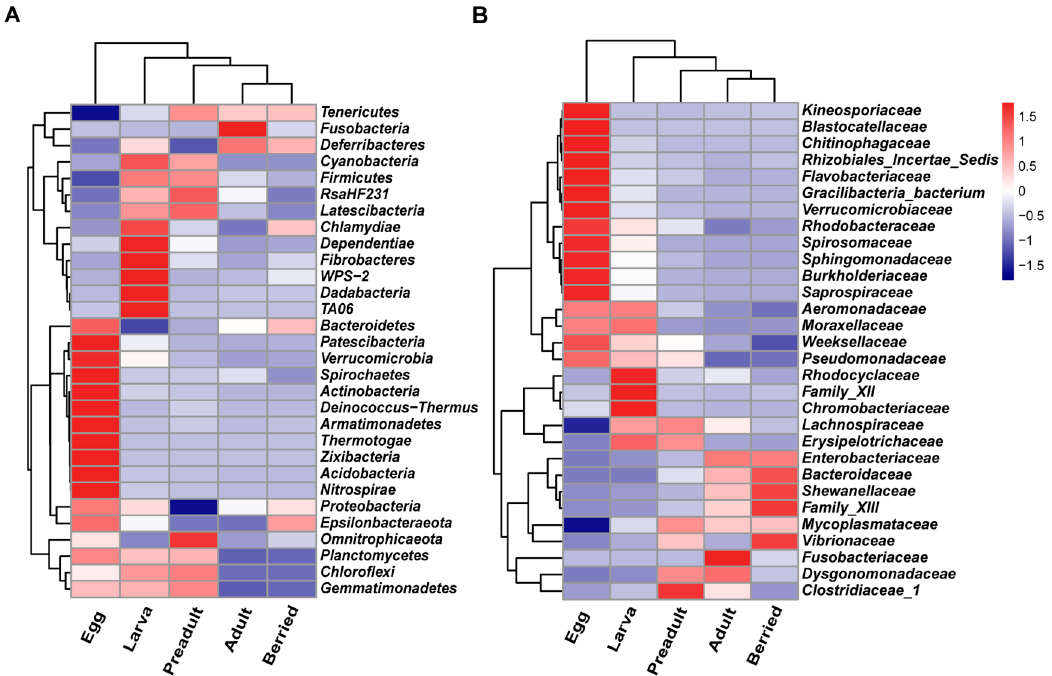
Figure 4. Heat map of the top 30 OTUs relative abundance at different developmental stages at the phyla level ( A ) or at the family level ( B ).